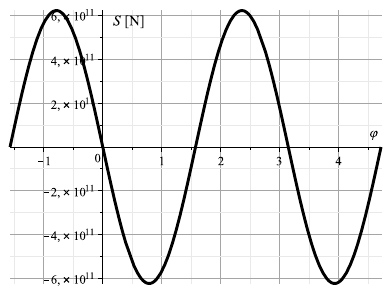
Figure 23: Plot of U ( φ ) (Example 5.3).